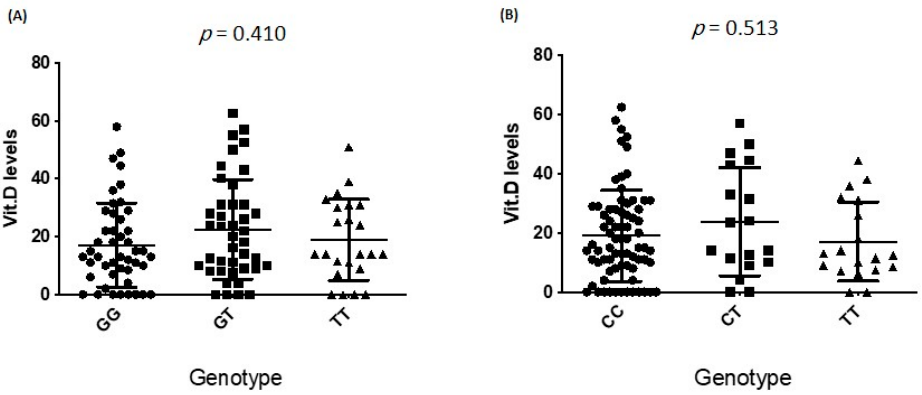
Figure 6. Association of vitamin D status with VDR and VDBP gene polymorphisms. Association of vitamin D status with ( A ) VDR and ( B ) VDBP genotypes. VDR: vitamin D receptor; VDBP: vitamin D-binding protein.